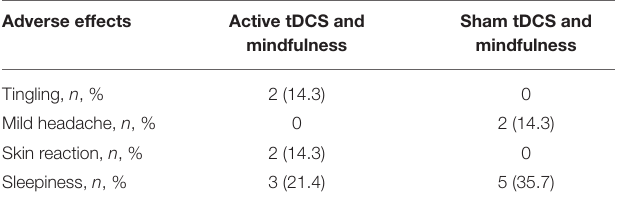
TABLE 2 | Distributed adverse effects on active tDCS and sham tDCS groups associated with mindfulness. Adverse effects